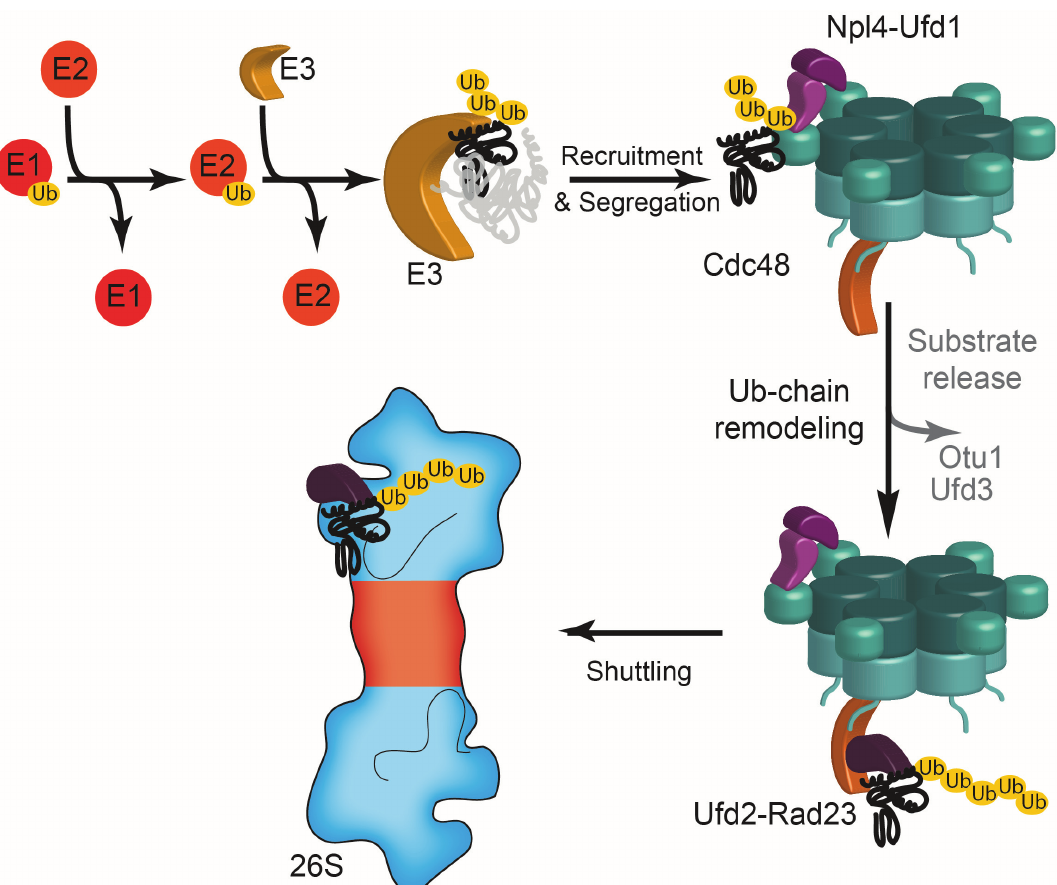
Figure 4. Cdc48-centered escort function for substrates of the UPS. An enzymatic cascade of Ub-activating enzyme (E1), Ub-conjugating enzyme (E2) and Ub ligase (E3) covalently links Ub moieties (yellow) to lysine residues of a protein that is targeted by the UPS. Via the Ub binding Npl4-Ufd1 complex (purple), Cdc48 (cyan) recruits the substrate. The ATP-dependent segregase activity of Cdc48 liberates the substrate from its non-ubiquitylated interaction partners. The fate of the substrate is then determined by Cdc48-associated Ub chain-remodeling cofactors. While the DUB Otu1 and Ufd3 may prolong the lifetime of the substrate by deubiquitylation and substrate release, respectively, the E4 enzyme Ufd2 (orange) extends the poly-Ub chain and facilitates the transfer of the substrate to the 26S proteasome by the shuttling Ub receptors Rad23 and Dsk2 (dark